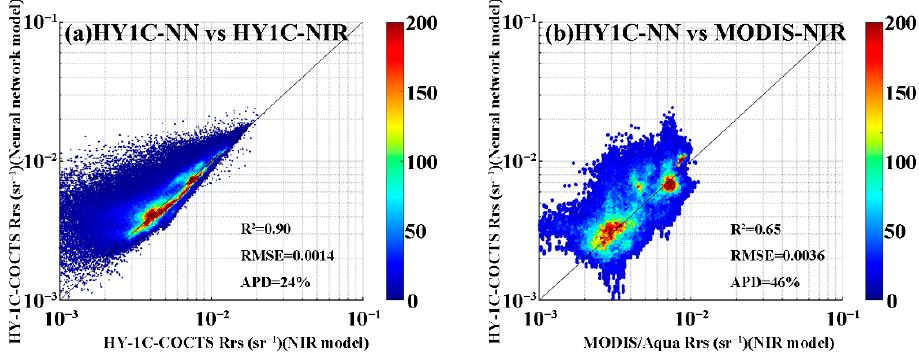
Figure 6 . Comparison of the 443 nm Rrs products retrieved by the neural network atmospheric correction algorithm and the inversion results of the near-infrared iterative atmospheric correction algorithm. ( a ) Comparison of the results of two algorithms for processing HY-1C-COCTS. ( b ) Comparison of the results of two algorithms for processing HY-1C-COCTS and MODIS/Aqua data.